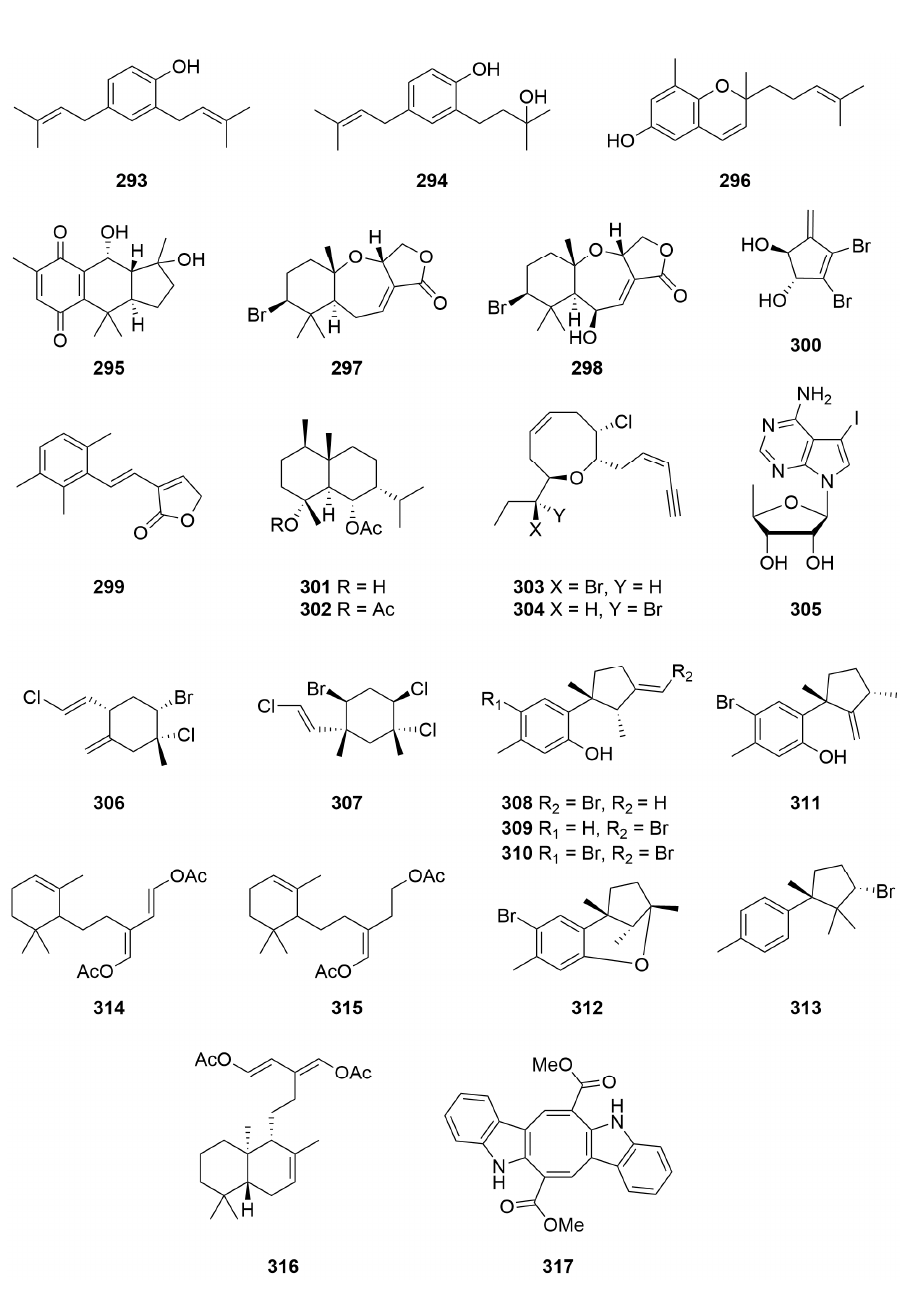
Figure 19. Compounds 293 to 317 .